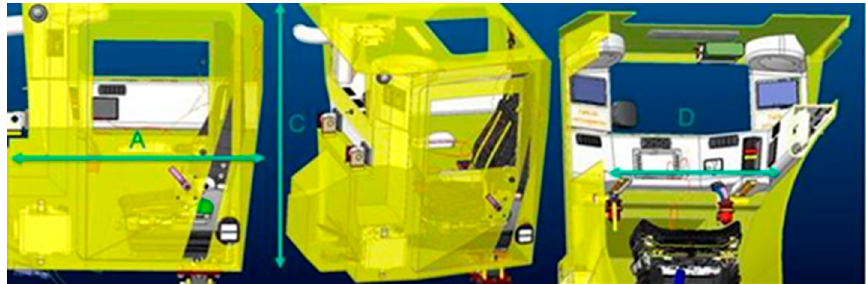
Figure 1. Cabin of a loader—autonomous mobile machine operating in underground mines. Internal dimensions: A—1275 mm, C—1335 mm, D—800 mm.